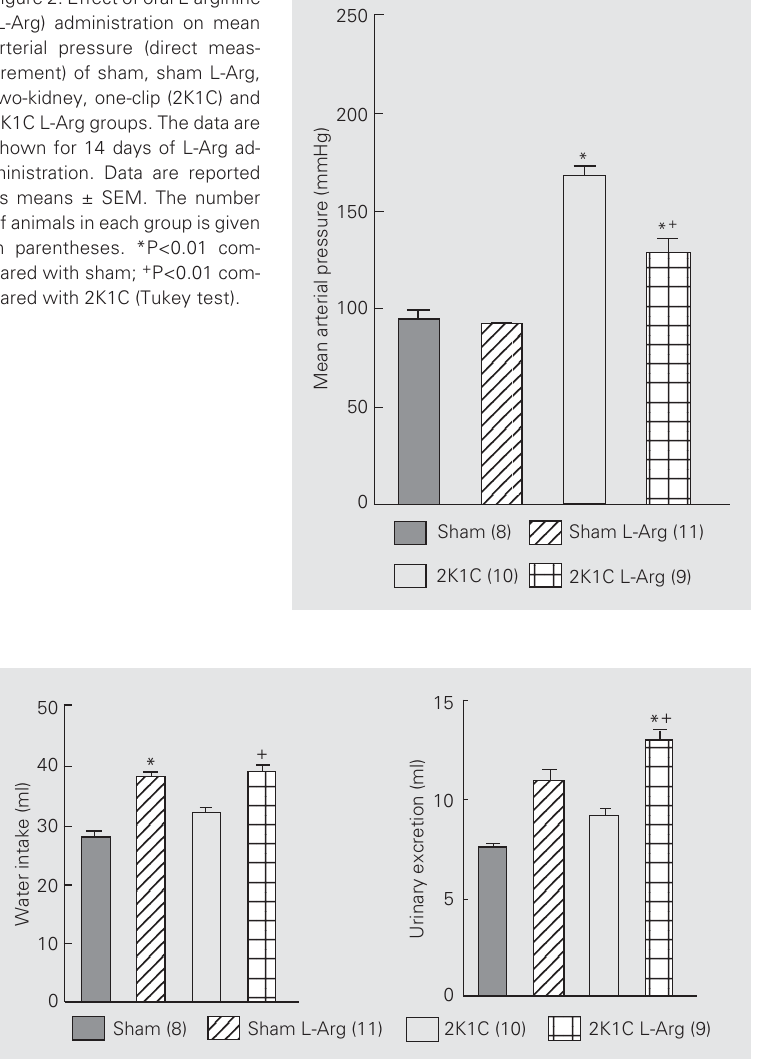
Figure 3. Water intake and excretion after oral L-arginine (L-Arg) administration to the sham and two-kidney, one-clip (2K1C) groups. The data are shown for 7 days of L-Arg administra- tion. Data are reported as means ± SEM. The number of animals in each group is given in parentheses.*P<0.01 compared with sham; + P<0.01 compared with 2K1C (Tukey